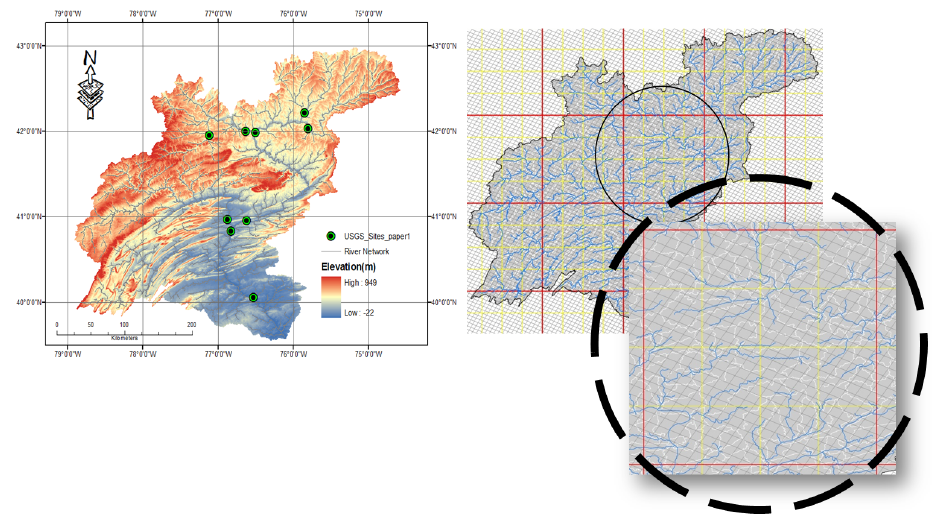
Figure 1. Study area (left panel) and precipitation product grids (right panel) over the Susquehanna River basin. The red grid indicates GLDAS (100km), yellow indicates TRMM3B42V7 (25km) and black indicates the stage IV radar rainfall product (4km).